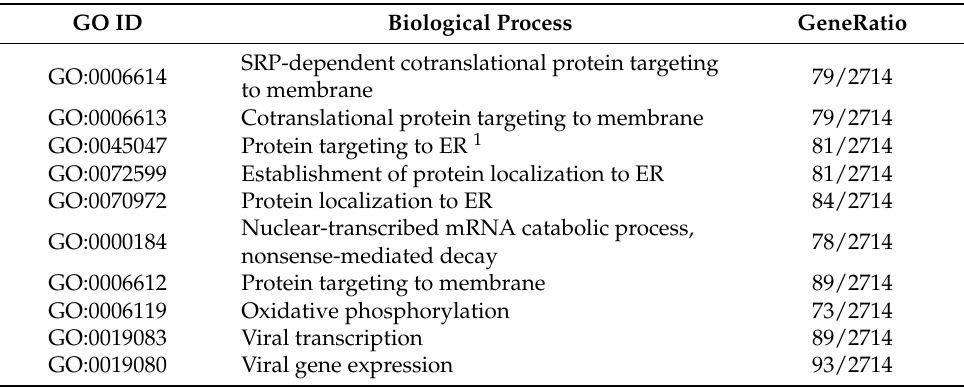
Table 8. Top 10 biological processes significantly (padj ≤ 0.01) enriched in genes differentially expressed in M2_C versus M0_C macrophages.